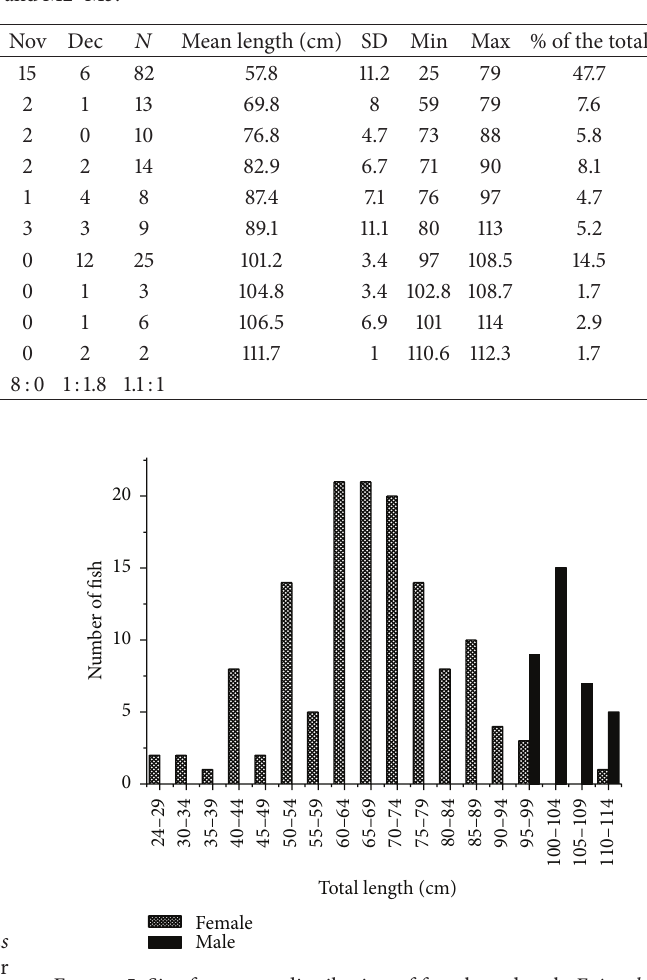
Table 2: Monthly frequency and average length (cm) for Epinephelus malabaricus according to maturity stages. F1 and F2 are not included in female (F):male (M) ratio. See Table 1 for descriptions of F1–F6 and M2–M5.